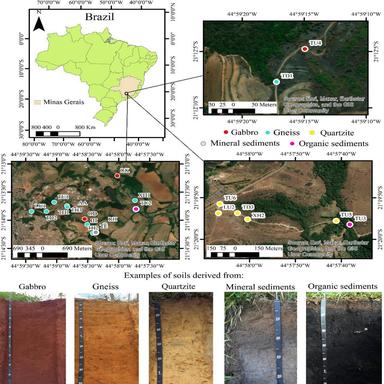
Study area location, sampling places and examples of some soil profiles investigated and derived from the dominant parent materials in the region. For symbology of the sampling places, please see